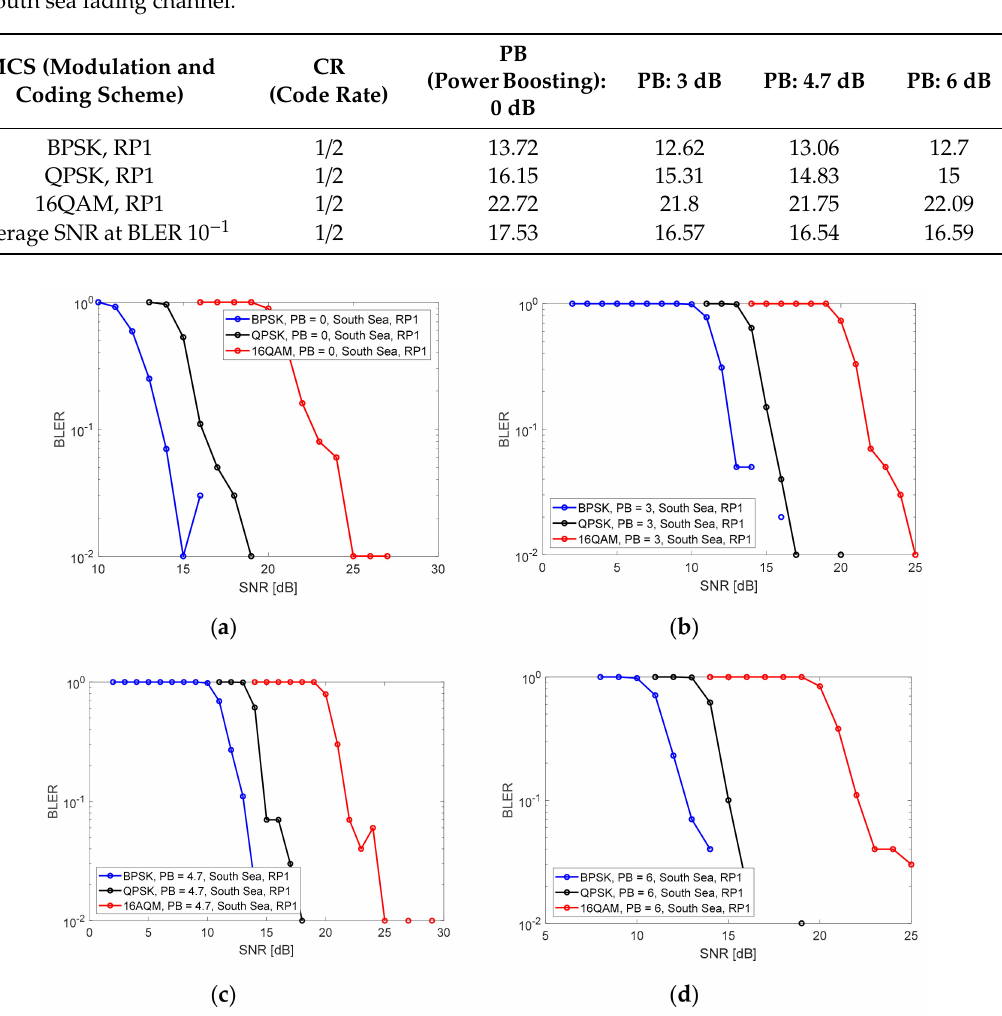
Figure 7. ( a ) Non-power allocation (PA) [0 dB], ( b ) PA [3 dB], ( c ) PA [4.7 dB], and ( d ) PA [6